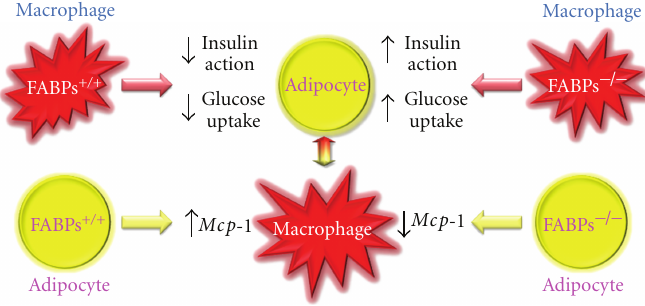
Figure 1: Interaction of adipocytes and macrophages. FABPs, FABP4, and FABP5, in adipocytes and macrophages, are critical for regulating inflammatory and metabolic responses in each type of cells and also interaction of the two types of